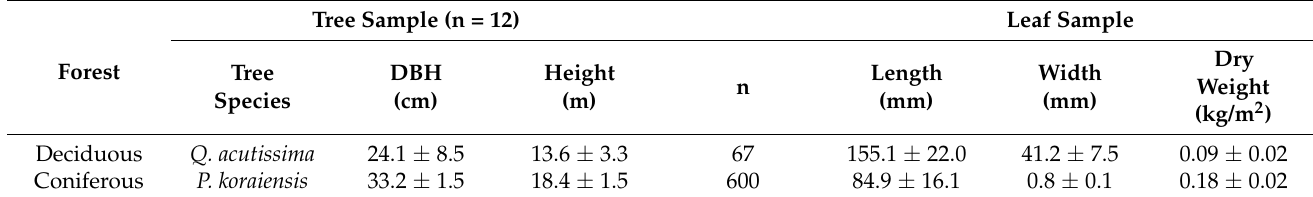
Table 1. Tree and leaf litter characteristics.